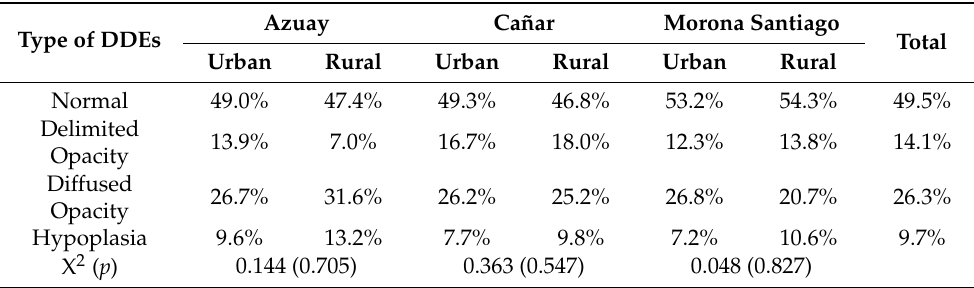
Table 3. Distribution of DDE types according to urban/rural environment in the provinces of Cañar, Azuay, and Morona